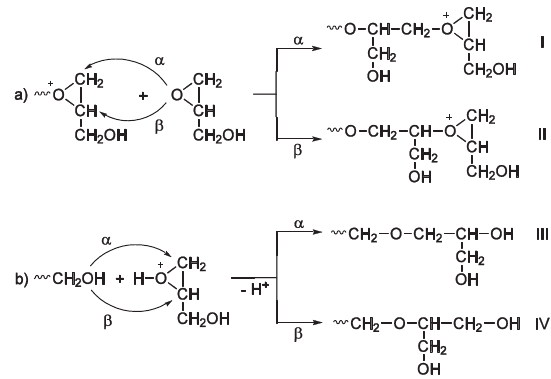
Figure 31. The microstructure of poly-glycidol: ( a ) Growth via an active chain end and ( b ) via an activated monomer mechanism.